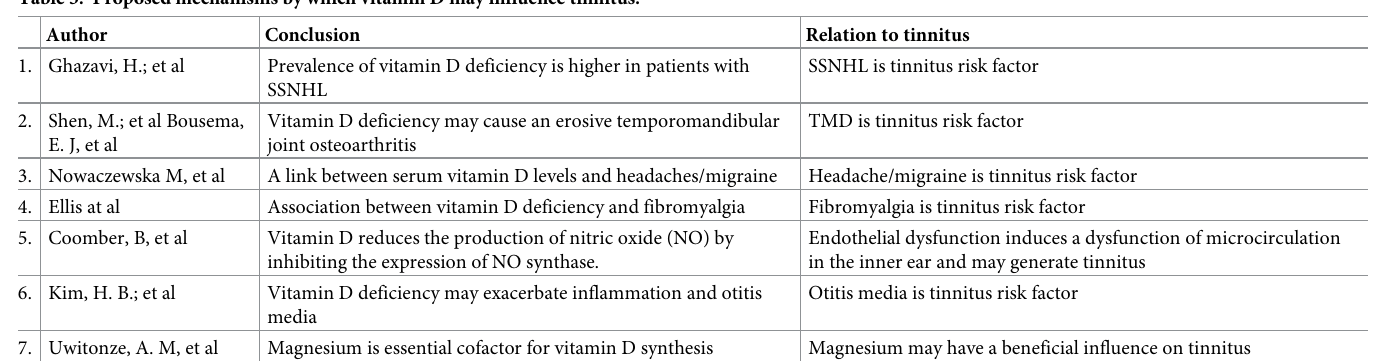
Table 5. Proposed mechanisms by which vitamin D may influence